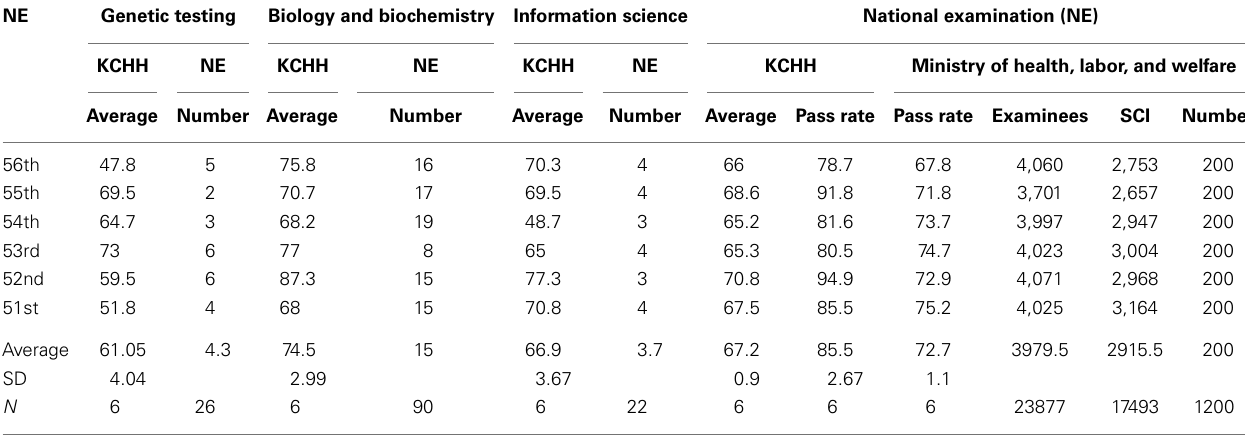
Table 2 |Test scores on the national examination for medical technologists in Japan . NE Genetic testing Biology and biochemistry Information science